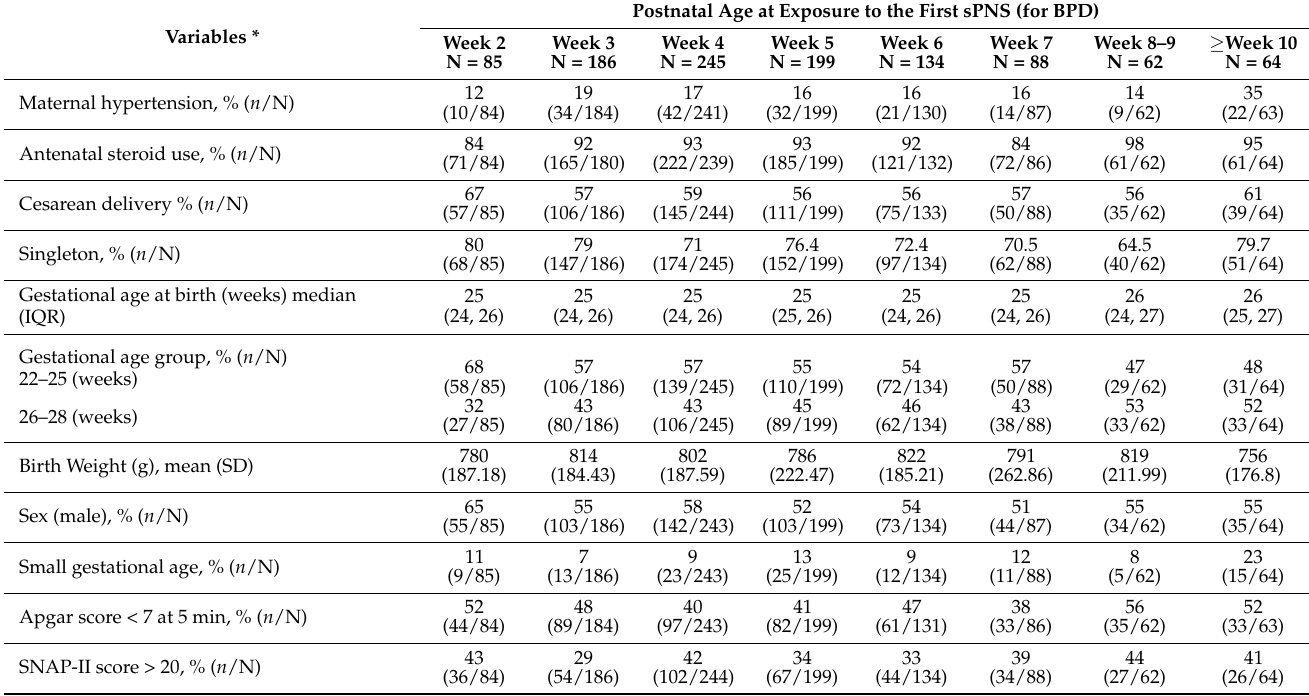
Table 3. Maternal and infant characteristics among the infants exposed to